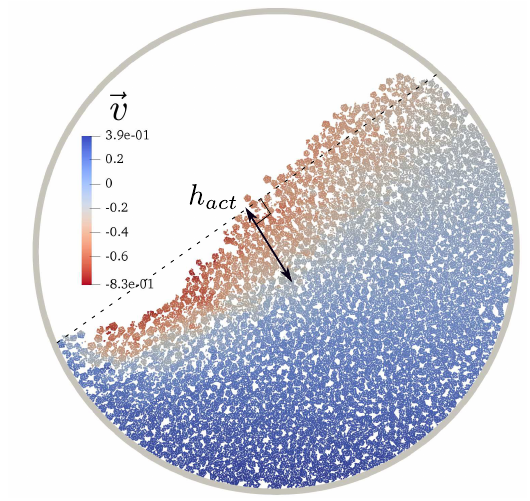
Figure 5. Mean active layer thickness h act normalized by the granular bed thickness h bed , for each sample of breakable poly- gons with di ↵ erent number of sides ( n sides ).